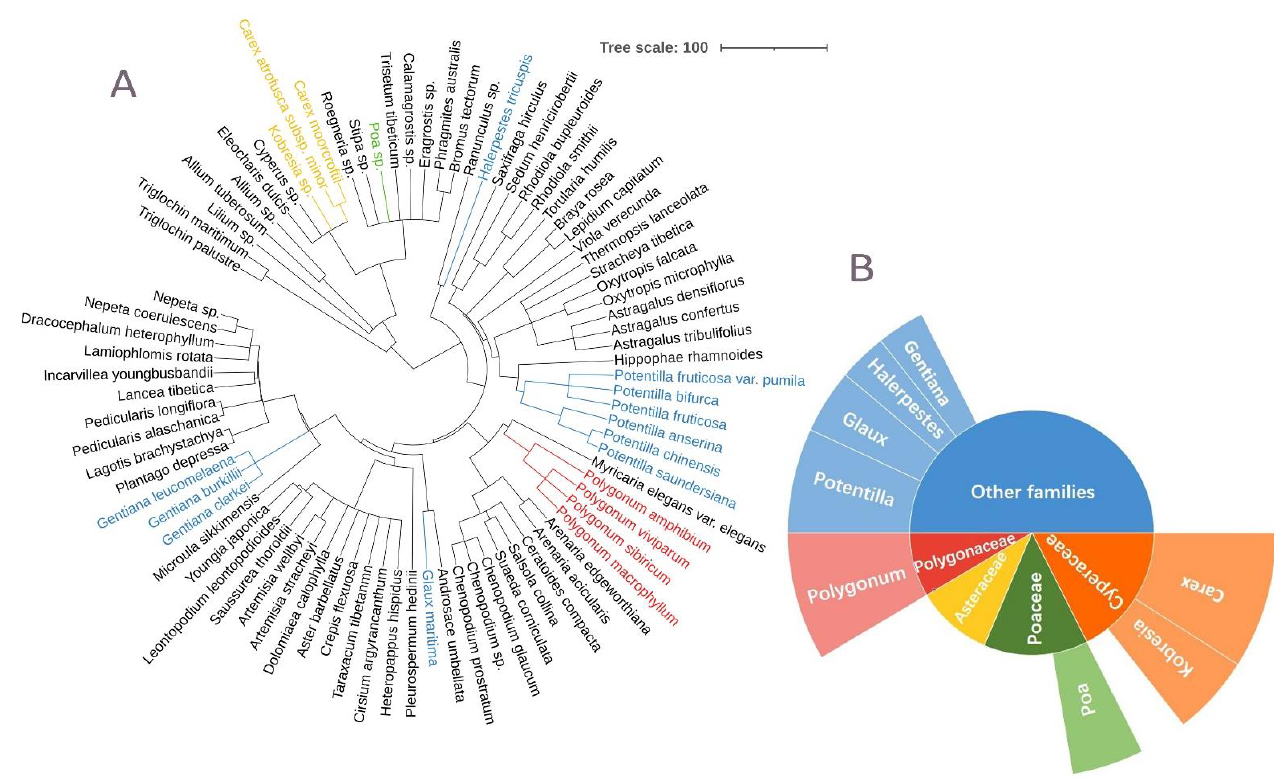
Figure 2. The phylogenetic distribution of all plants in this study ( A ) and the dominant families (the accumulated relative frequency is 50%) and genus (the accumulated relative frequency is approximately 1/3, ( B )). The colour scheme used for species in ( A ) matches taxa shown in ( B ).